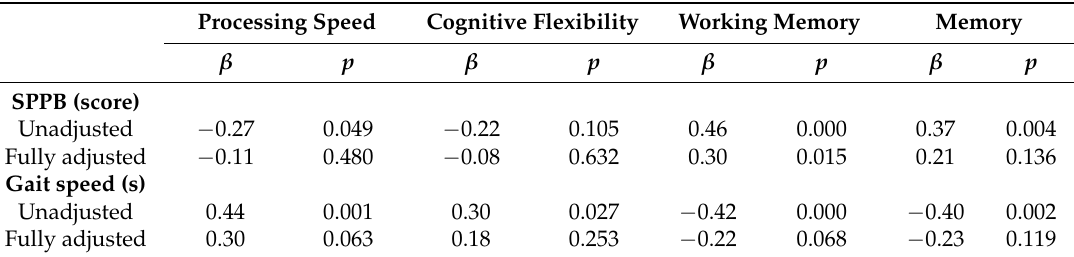
Table 4. Association between physical function and gait speed with measures of cognitive function. (fully